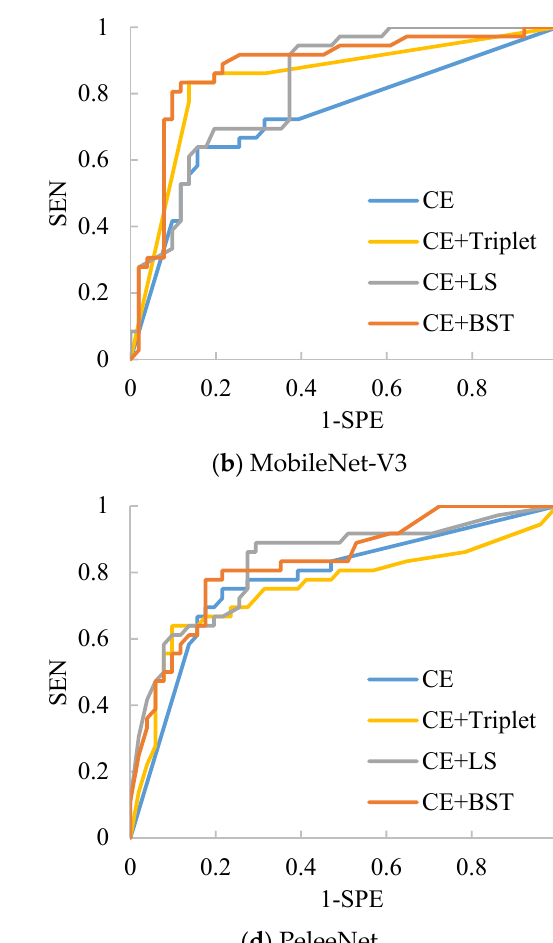
Sensors 2021 , 21 , x FOR PEER REVIEW